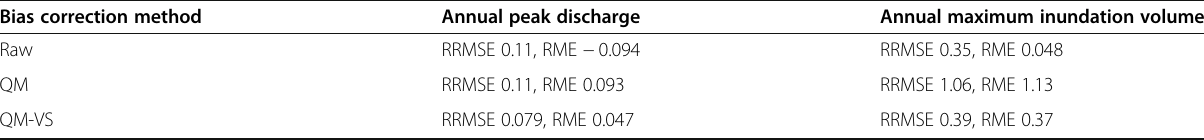
Table 1 Evaluation of annual peak discharges and annual maximum inundation volume with a raw/bias-corrected NHRCM against those with GSMaP Bias correction